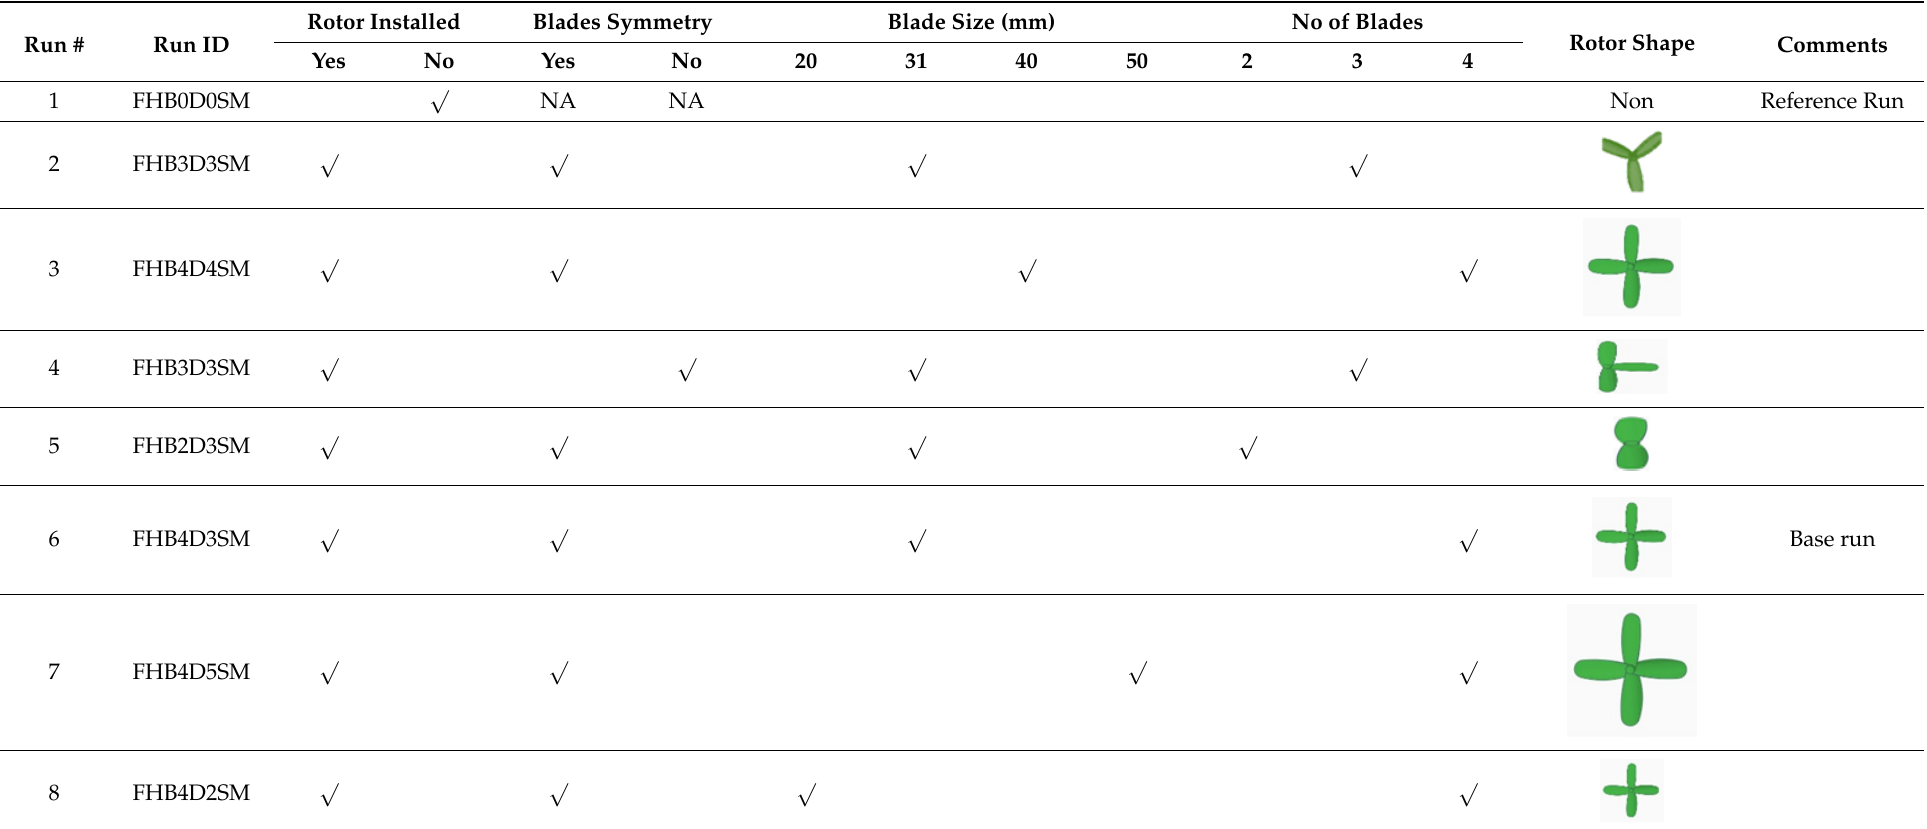
Table 1. Characteristics of the Conducted Experimental Runs.